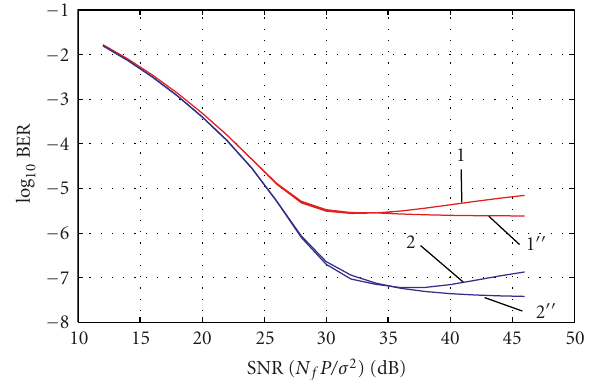
Figure 8: BER performance of MC-CDMA for N f = 64 with MMSE equalizer, averaged over 10 6 realizations of the channel model given in [12] with tap variances normalized such that the total variance is one (Plots 1, 2, 3 are without regularization, 1 (cid:7) ,2 (cid:7) ,3 (cid:7) are with regularization based on the threshold SNR estimated as given in Section 5.3 with RFO = 0.05, plots 1 (cid:7)(cid:7) ,2 (cid:7)(cid:7) ,3 (cid:7)(cid:7) are with regularization based on the threshold SNR computed from (26), plots (1,1 (cid:7) ,1 (cid:7)(cid:7) ), (2,2 (cid:7) ,2 (cid:7)(cid:7) ), and (3,3 (cid:7) ,3 (cid:7)(cid:7) ) correspond to RFOs = 0.05, 0.03 and 0.01, respectively, and symbols are from 4-QAM constellation with P = 1).